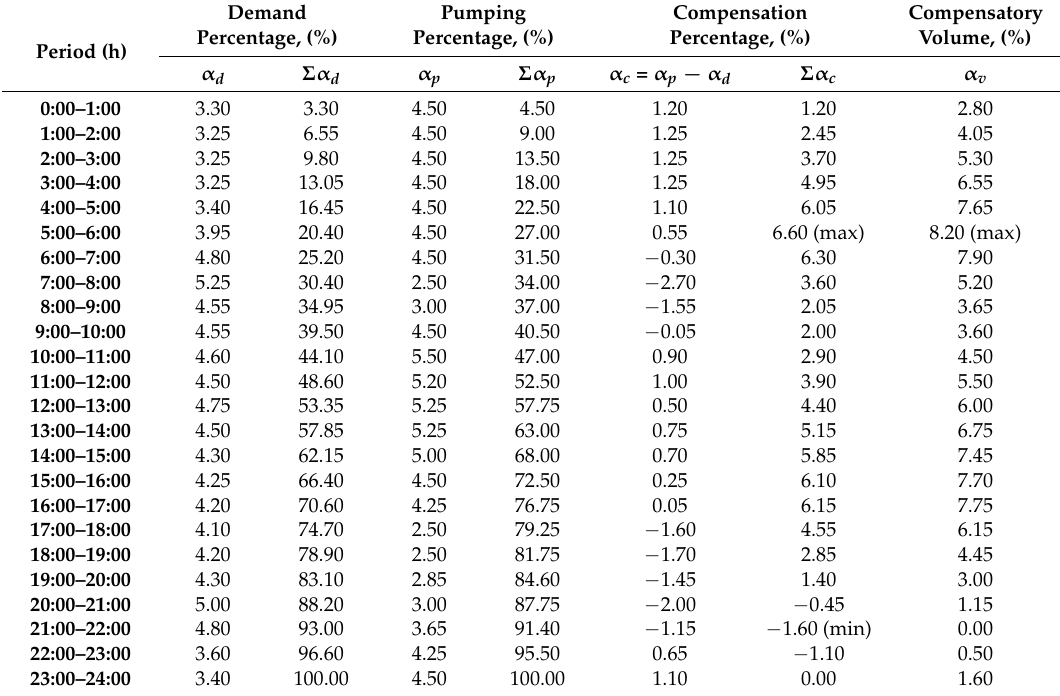
Table 2. Estimation of elevated tanks capacity for hour demand compensation.